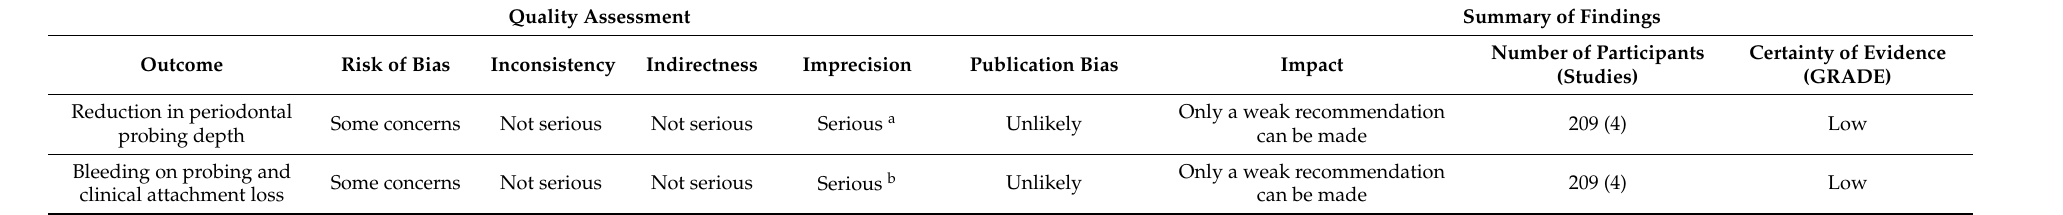
Table 2. Summary of